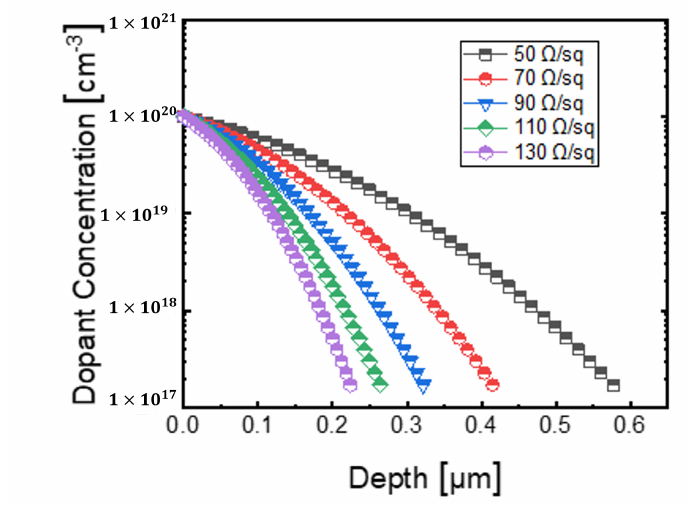
Figure 4. Variation in the R sheet by fixing the emitter dopant concentration 1 × 10 20 cm − 3